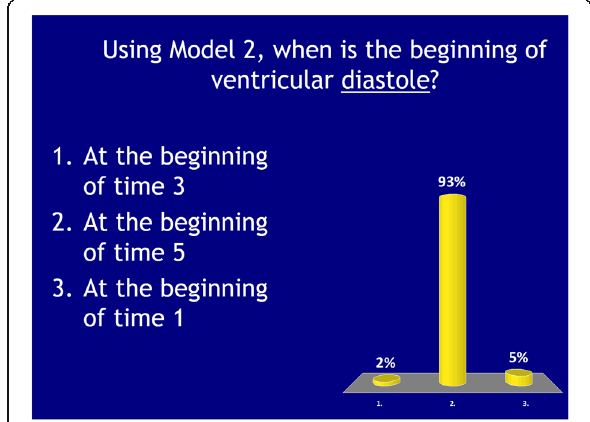
Fig. 1 Example of a biology ARS question as it was delivered in class